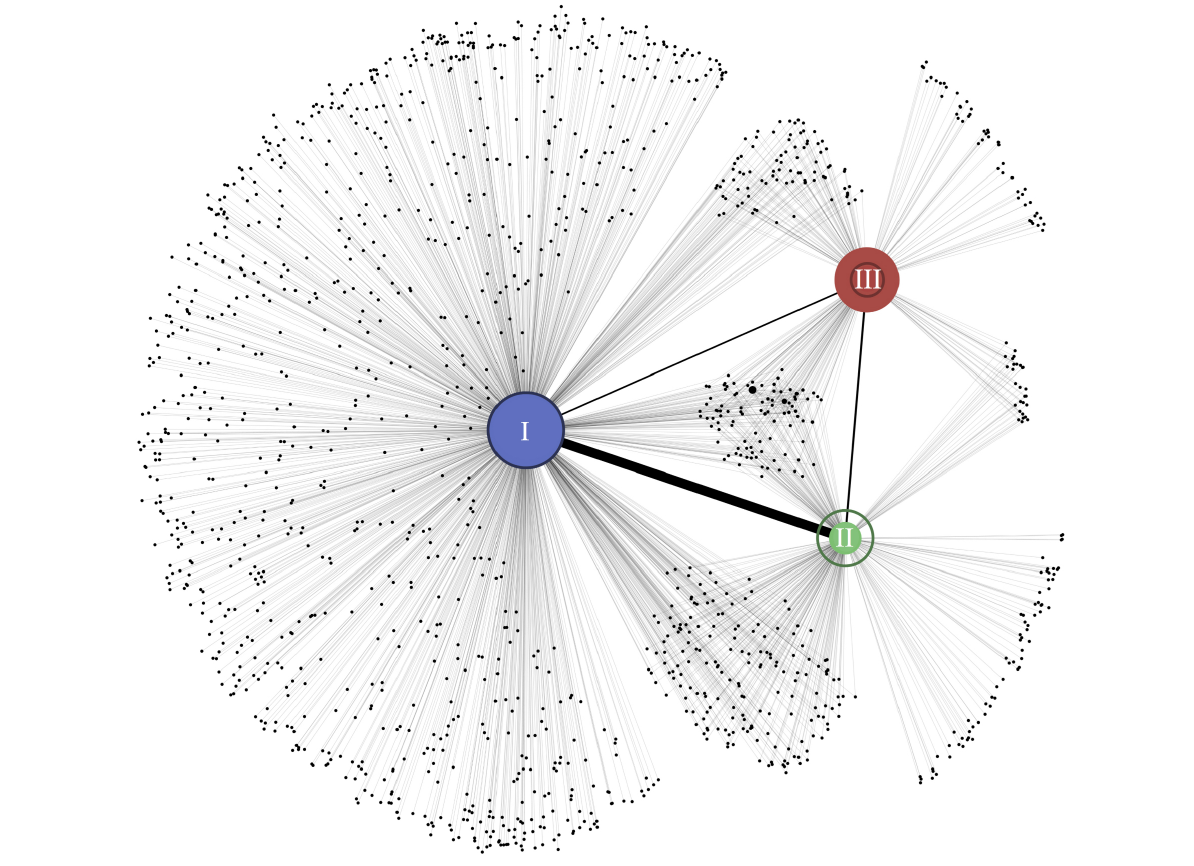
Figure 1. Visualization of connectivity between 1420 communities identified at maximum modularity (Q). Each circle represents a community with filled circle diameter indicating the relative number of within-module edges. Lines joining pairs of communities are drawn with a thickness that is proportional to the number of edges connecting them. The largest 3 communities (community I, II, and III) are labeled and filled in color. Darker rings superimposed on communities I, II, and III are proportional in diameter to the number of nodes making up